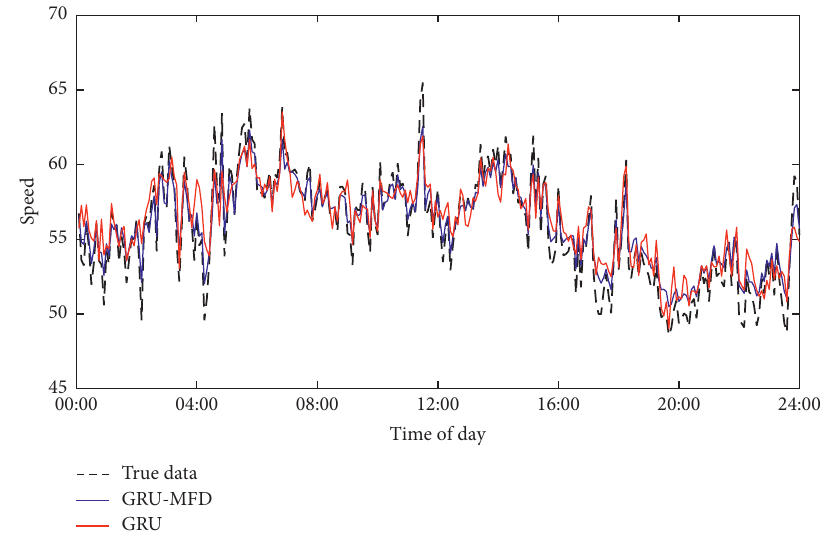
Figure 18: Prediction results on July 5, 2018, Section 2.